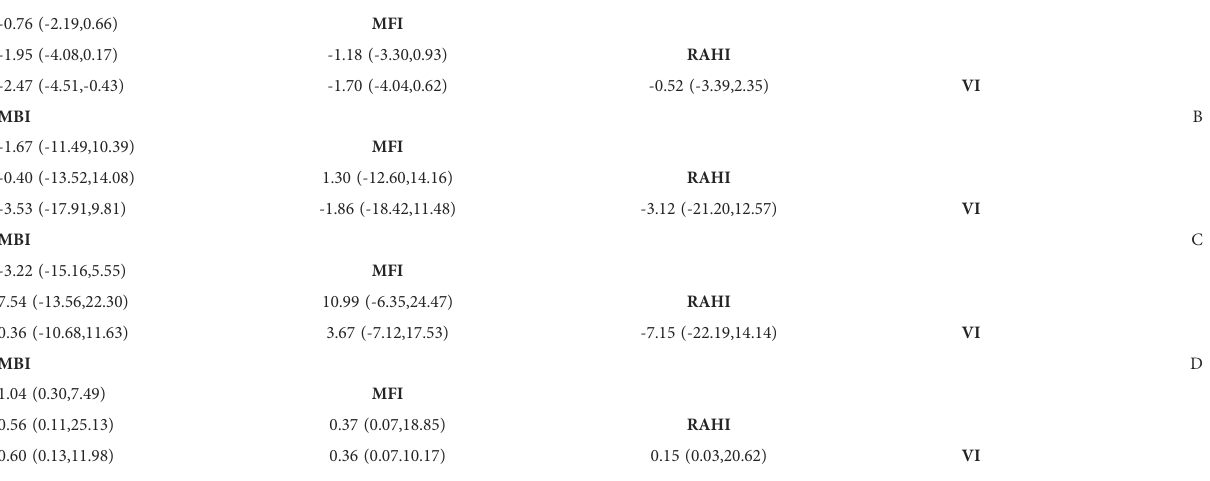
TABLE 4 League table of primary outcomes.